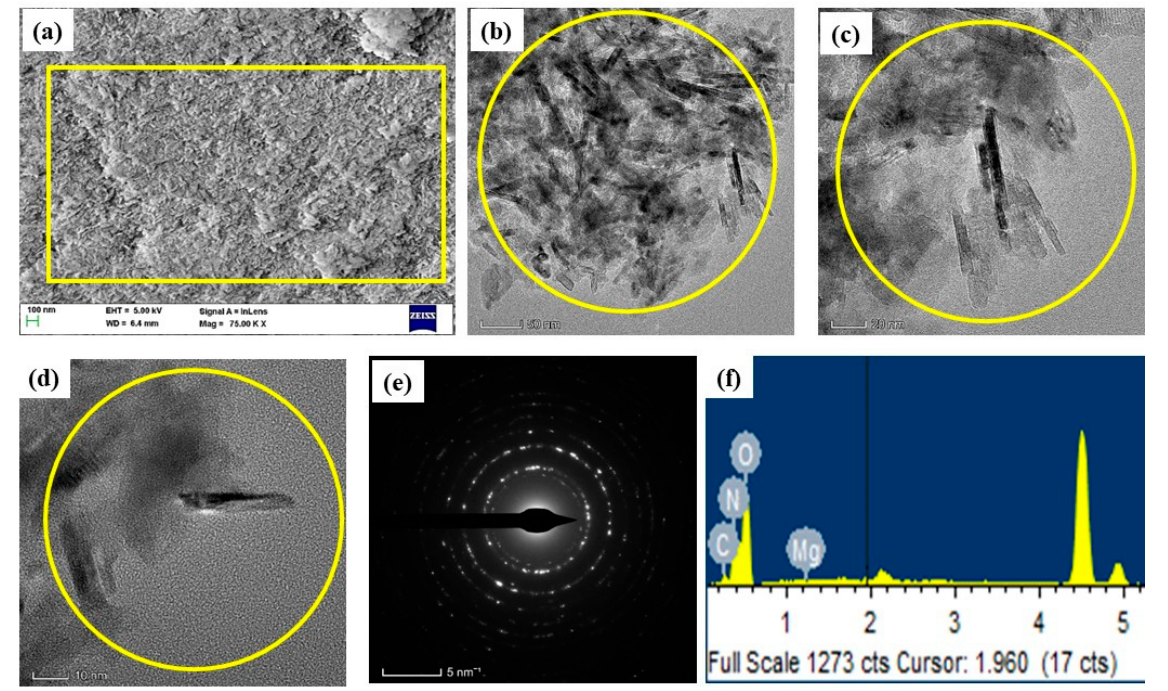
Figure 3. Electron Microscopic pattern of the MgO-Chitosan-Pluronic F127-Escin NPs: Lower and higher magnification FESEM image ( a , b ) TEM image ( c , d ), SAED pattern ( e ) and EDAX spectrum ( f ) of MgO-Chitosan-Pluronic F127-Escin NPs. Scale bar; (a) =100 nm, (b) = 50 nm, (c)= 20 nm, (d) = 20 nm, (e)= 5 nm.